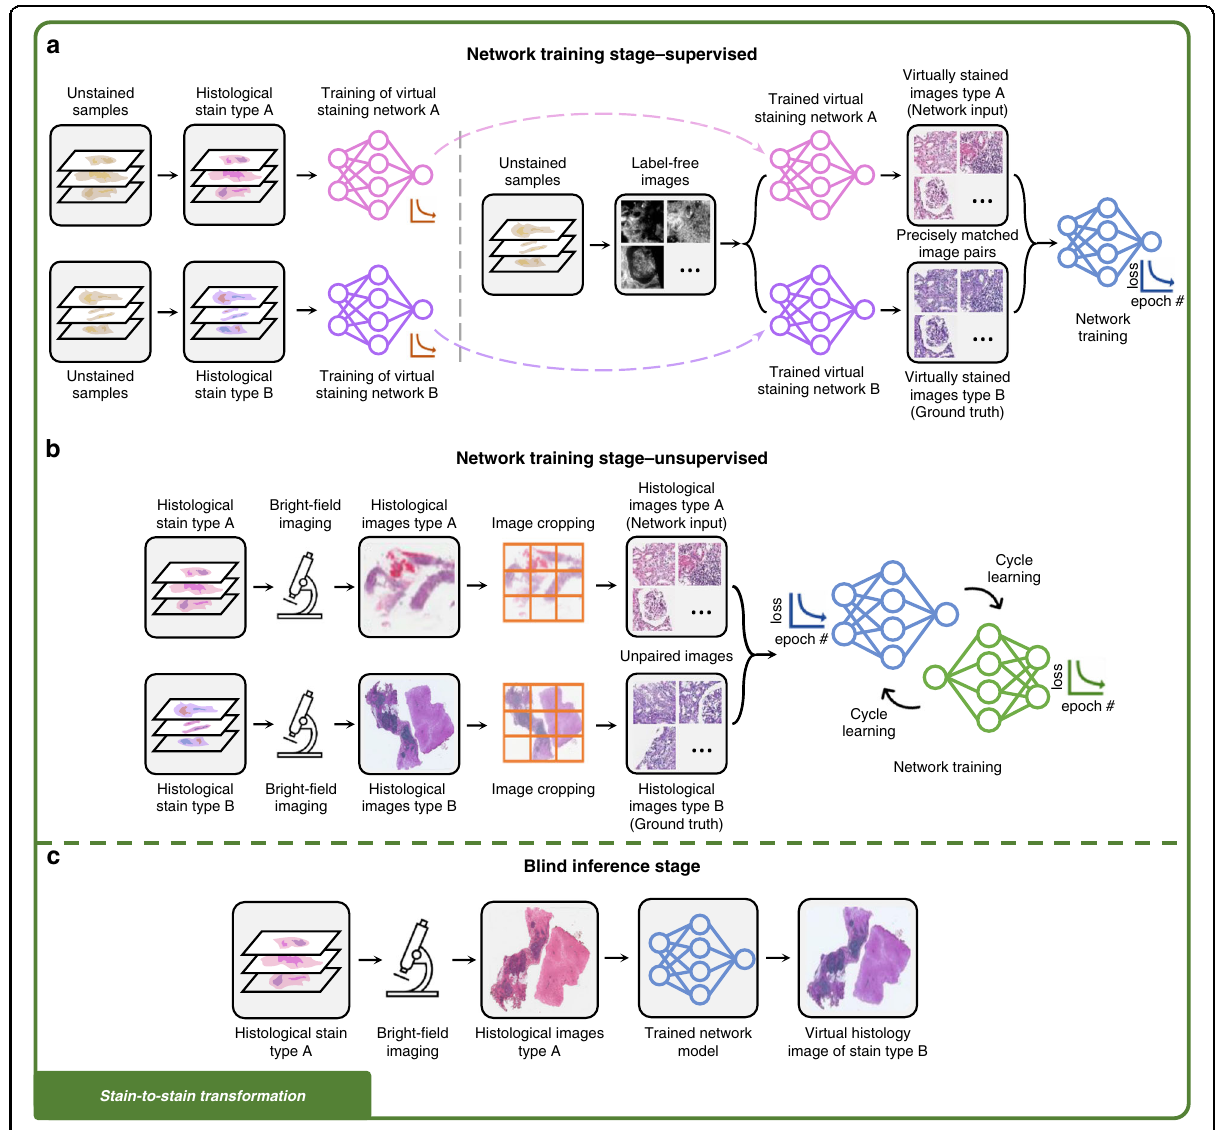
Fig. 3 Training and inference of stain-to-stain transformation networks. a Training of a stain-to-stain transformation network using the supervised scheme. b Training of a stain-to-stain transformation network using the unsupervised scheme, in which input and ground truth images are not necessarily paired. c Blind inference of a trained stain-to-stain transformation model. Additional histological stain types can be generated from the existing stain, providing additional diagnostic information without altering the current histopathology work fl